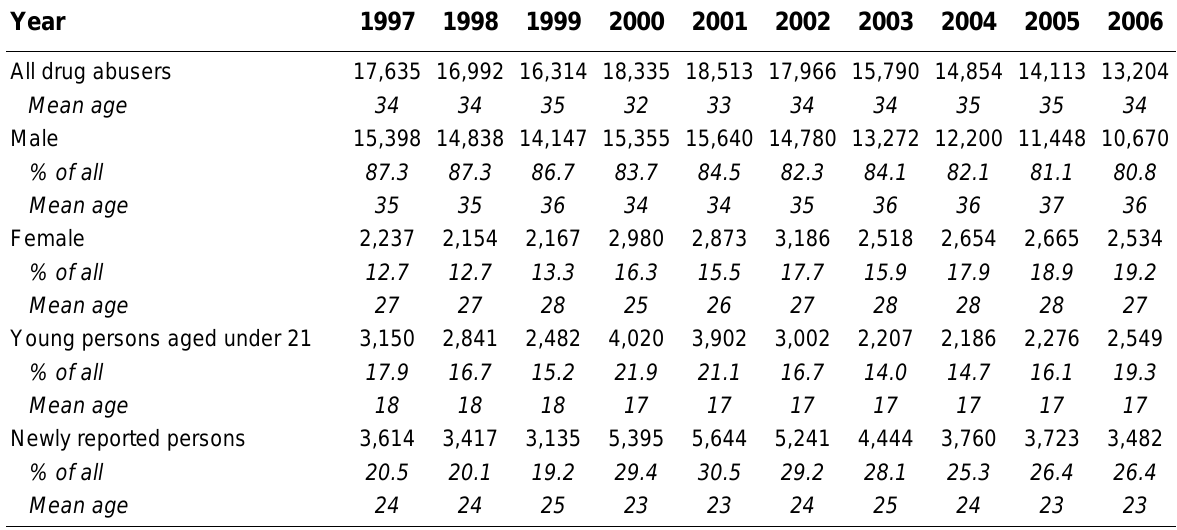
Substance Abuse Figures Reported in the Central Registry of Drug